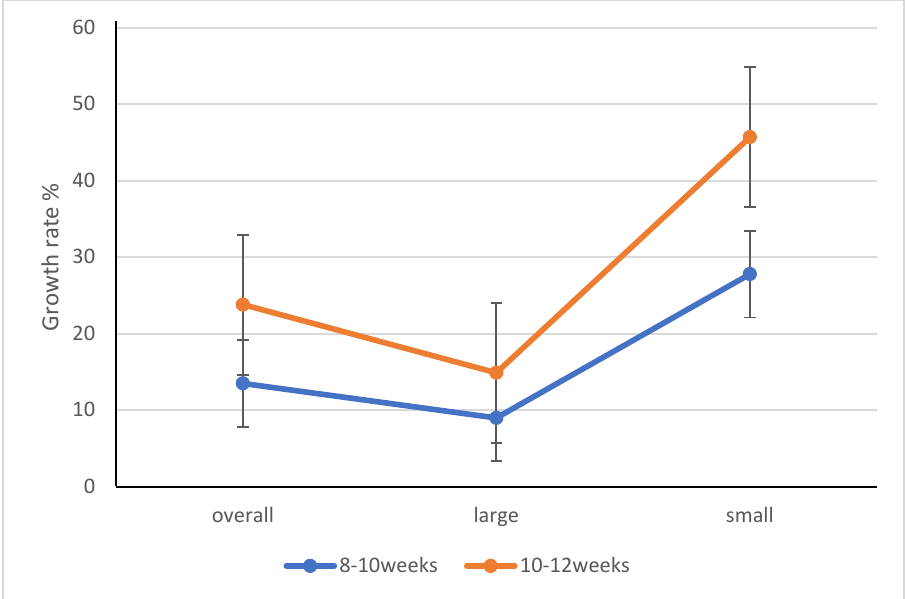
Table 5. Average surface area (SA)/body mass (BM) ratio, length, and width of yellow mealworm at week 12. Large Small